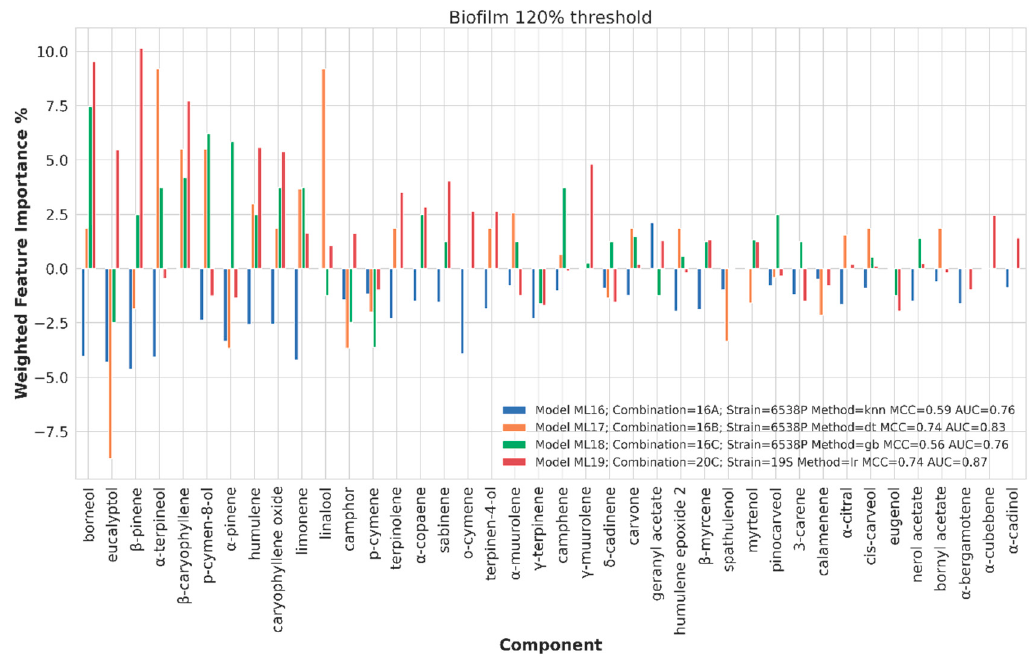
Figure 8. Weighted feature importance (WFI) plot for models obtained on the dataset binarized at 120% biofilm inhibition. Positive bars are associate with inhibition of biofilm production, whereas negative bars are associated with augmented biofilm production.